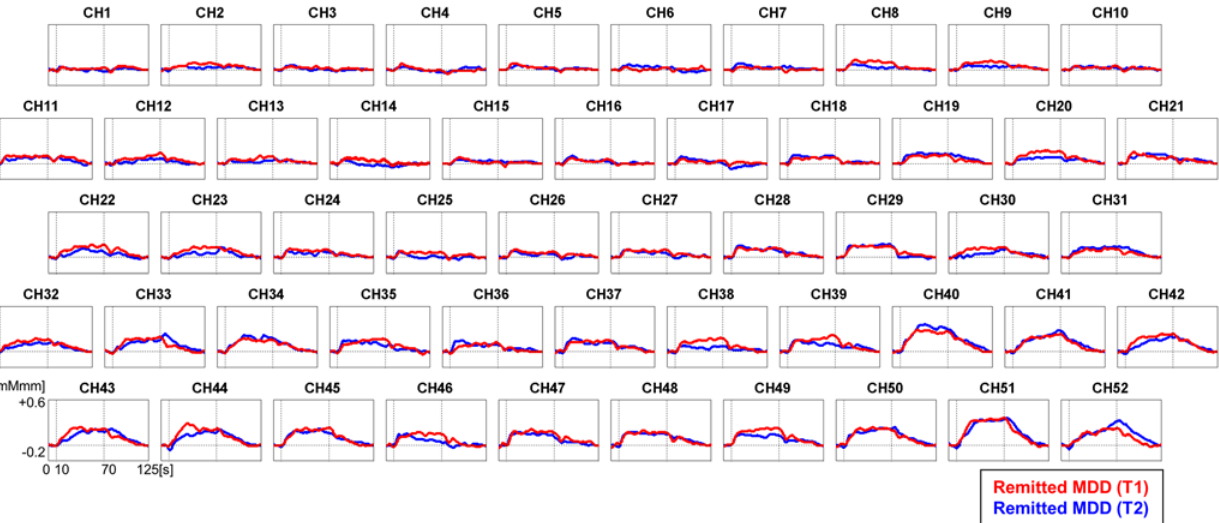
Fig 3. Grand average waveforms of [oxy-Hb] changes during VFT in the fronto-temporal brain regions in remitted MDD. Red line represents remitted MDD (T1: baseline) and blue line represents remitted MDD (T2: after treatment). oxy-Hb, oxygenated haemoglobin signal; VFT, Verbal fluency task; MDD, Major depressive